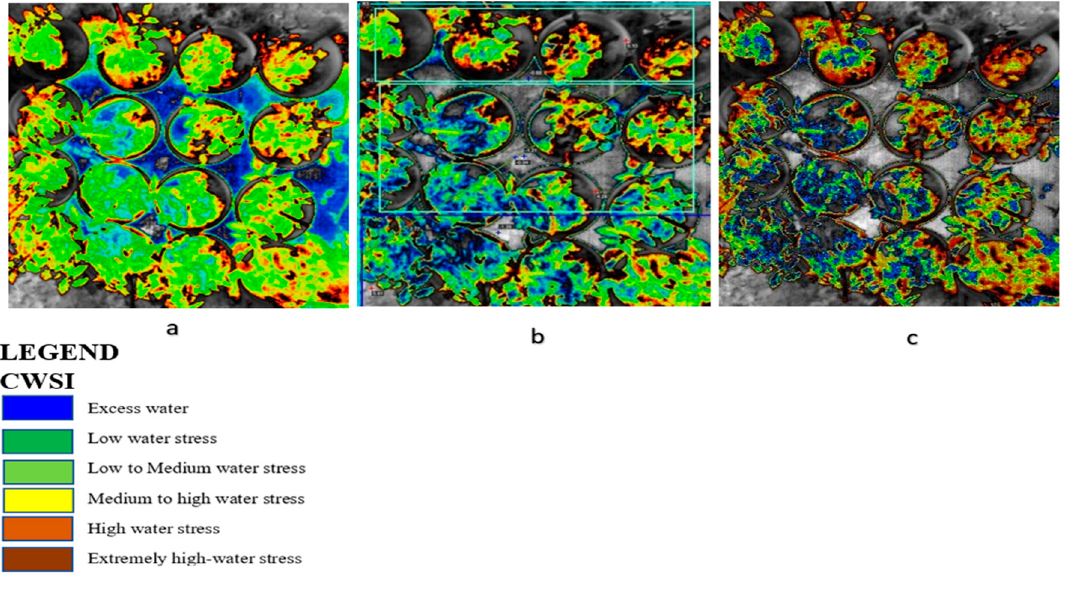
Figure 5. CWSI tiff images from WIRIS CorePlayer at different CWSI modes. ( a ) Empirical mode, ( b ) theoretical mode, and ( c ) differential mode revealing water stress with color mapping in tomato plants.